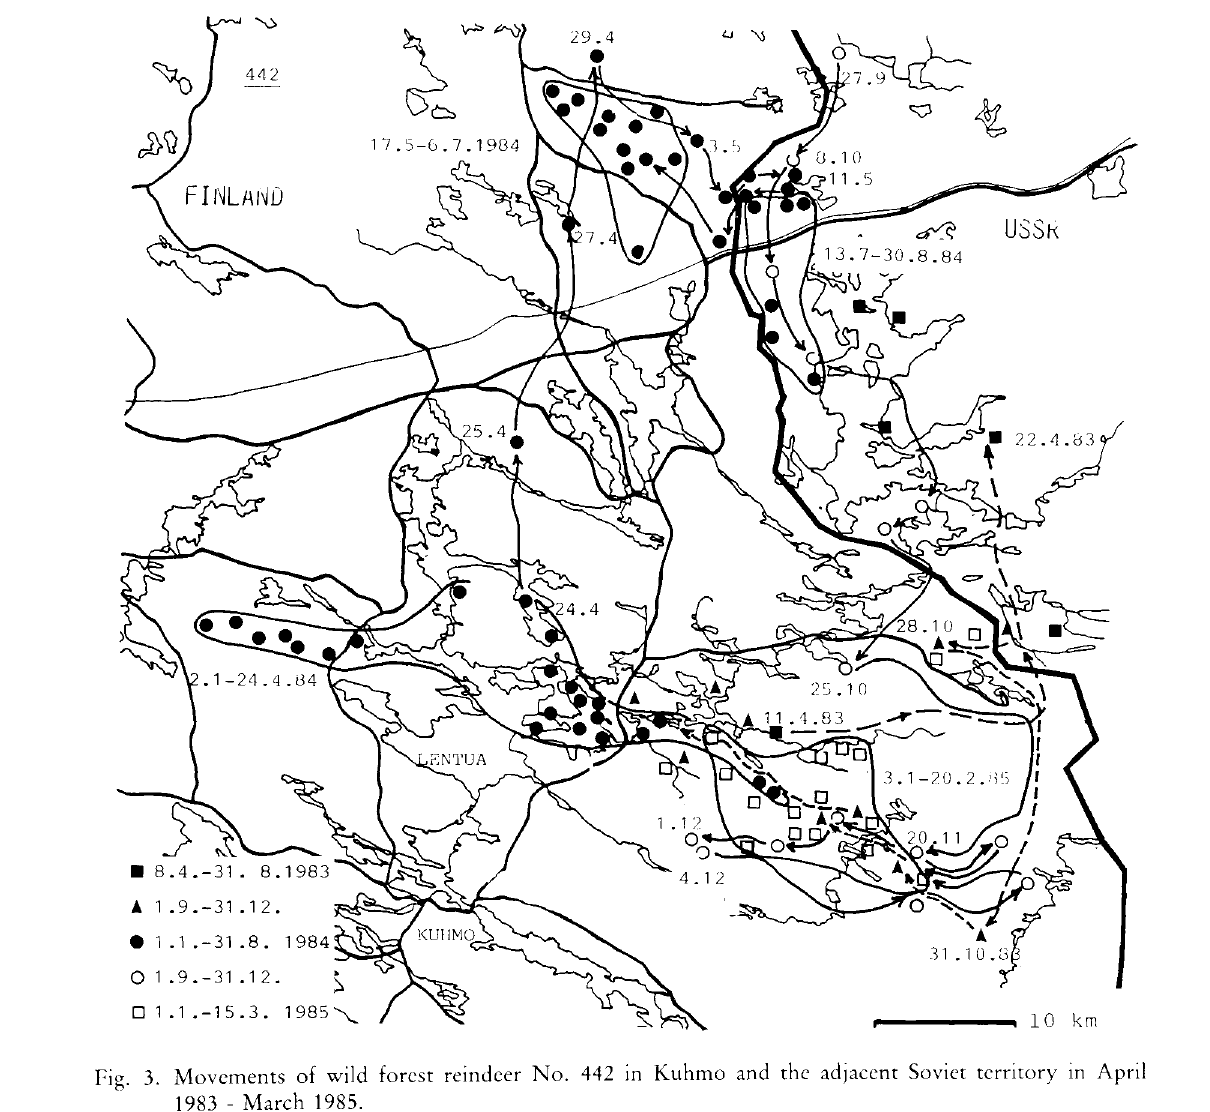
Fig. 3. Movements of wild forest reindeer No. 442 1983 - March